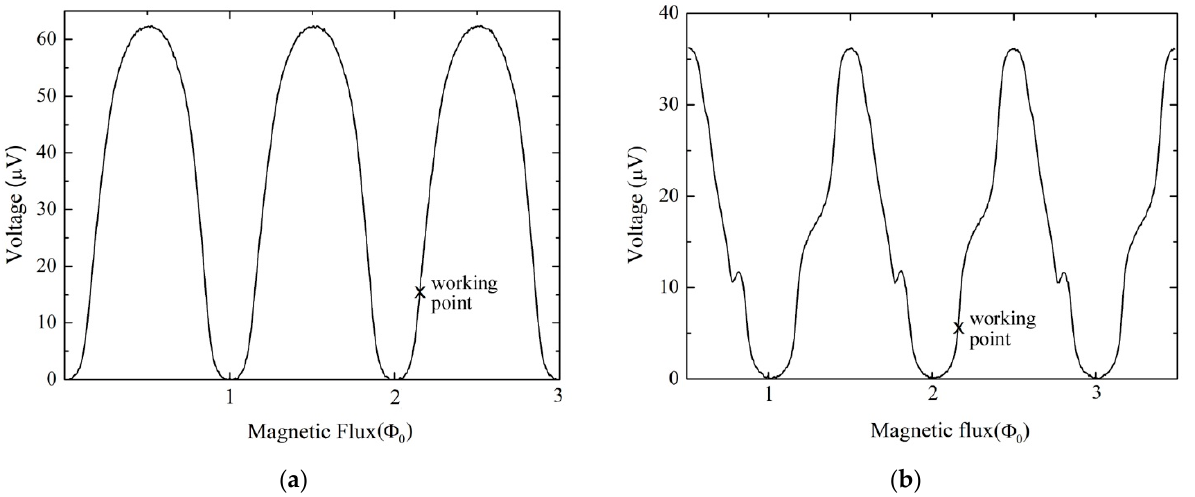
Figure 2. Voltage vs. magnetic flux characteristics of the SQUID current sensors in parallel ( a ) and series configuration ( b ), measured at T = 4.2 K. The bias currents are 26 and 28 µA for the parallel and series configuration, respectively. The crosses indicate the working point for the noise measurements corresponding for both configurations to about 0.15 Φ 0 with respect a minimum (n Φ 0 ).